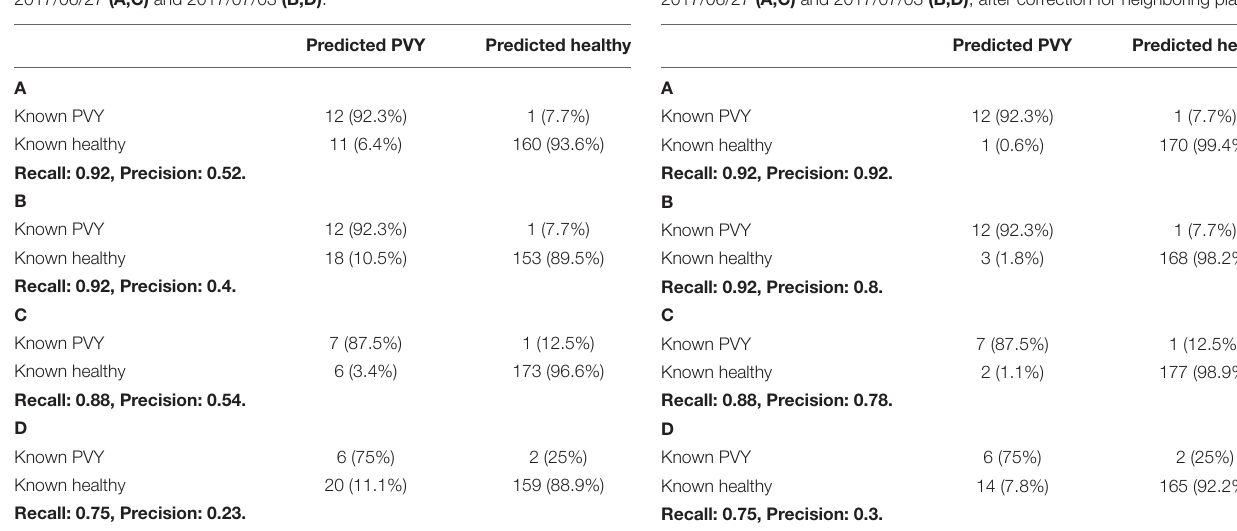
Dropout Resulting Resulting normalization ( p = 0.5) feature maps resolution